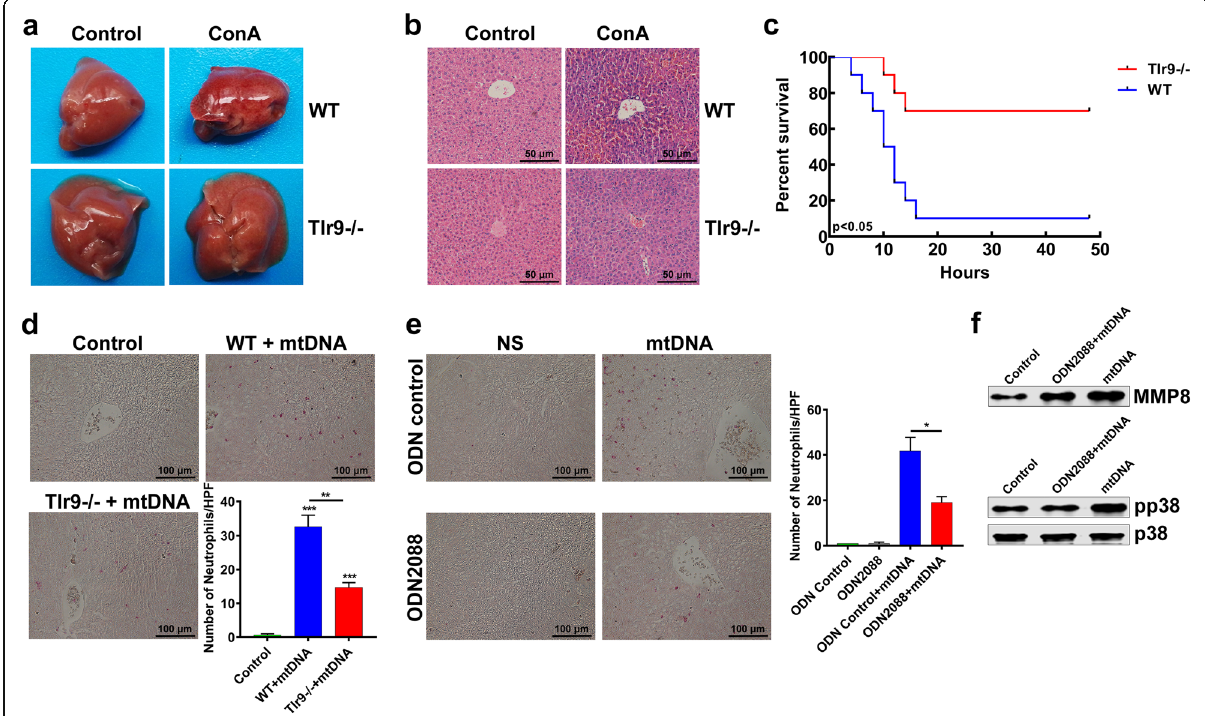
Fig. 5 ConA induced hepatic inflammation through TLR9 pathway. a The liver injury was less severe in Tlr-9 − / − mice after ConA injection. b The HE staining result of liver sections suggested less hepatocytes death in Tlr-9 − / − mice than that in WT mice after ConA injection. c The survival time of Tlr-9 − / − mice treated with ConA was significantly longer than that of WT mice treated with ConA. d Significantly decreased infiltration of esterase-positive neutrophils was observed in the liver of mtDNA-treated Tlr9 − / − mice, in comparison with mtDNA-treated WT mice. e The WT mice pretreated with ODN2088 had less neutrophils infiltration in liver after mtDNA injection. f ODN2088 suppressed the mtDNA-induced secretion of MMP8 and the activation of p38-MAPK pathway in neutrophils. ( *p < 0.05, **p < 0.01, ***p < 0.001